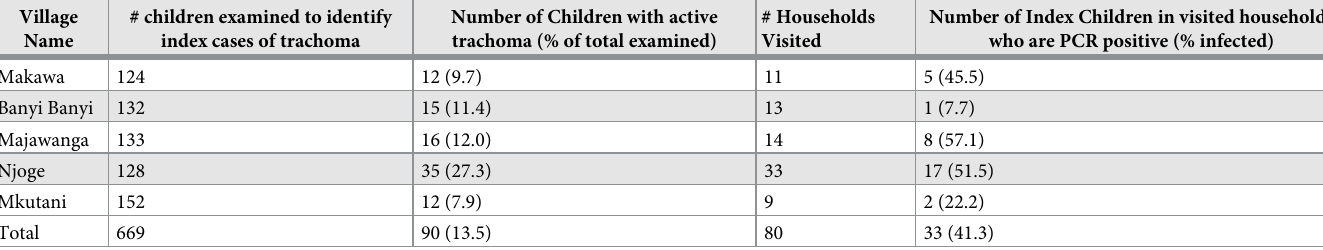
Table 1. Trachoma prevalence in villages and visited